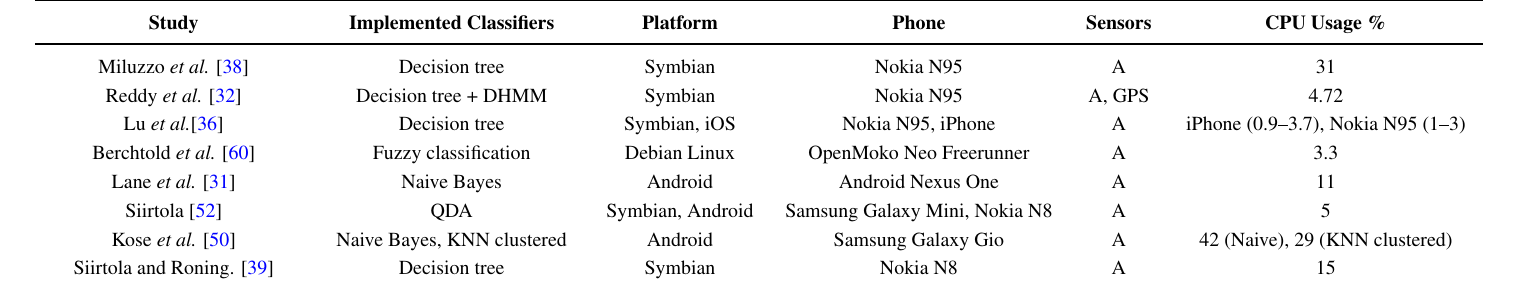
Table 8. Studies with CPU usage analysis.